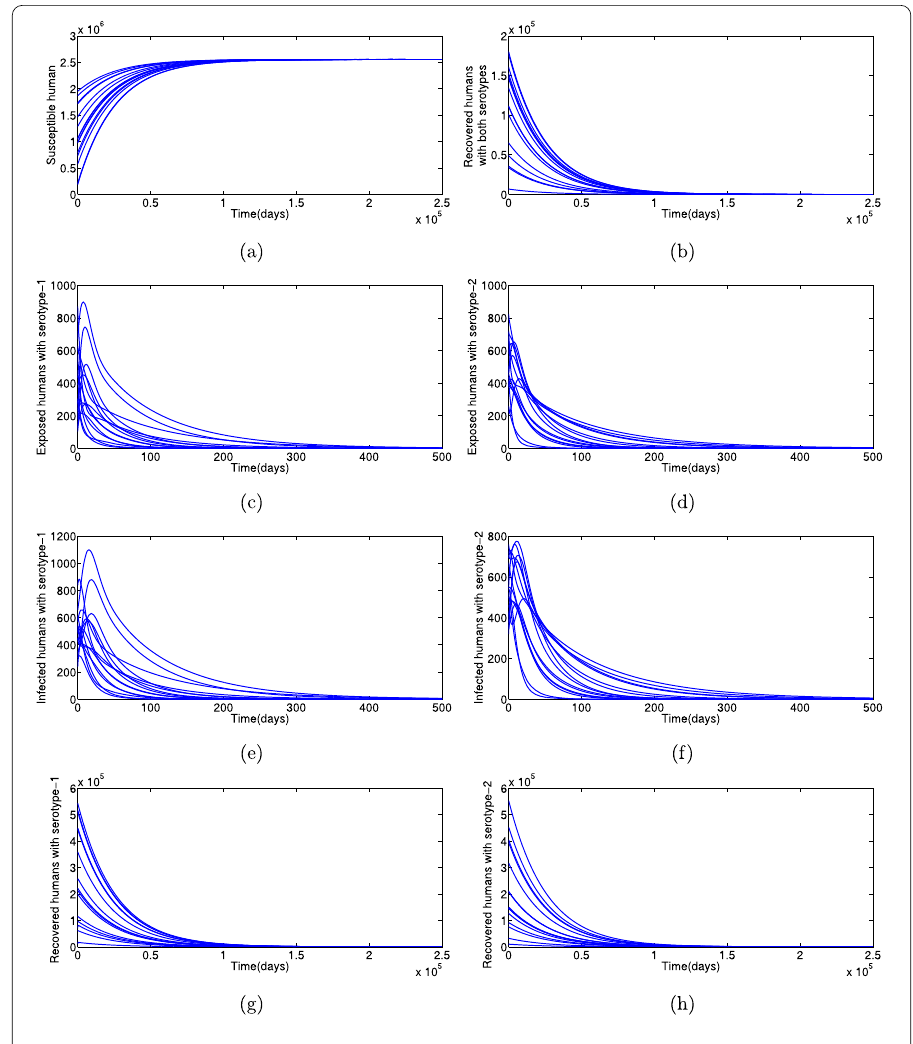
Figure 2 Time series plots of the multi-serotype dengue model (2.4)–(2.5) with different initial sizes of the sub-populations. The parameter values are given in Table 2 at which ( R n 1 = 0.9747, R n 2 = 0.9851)